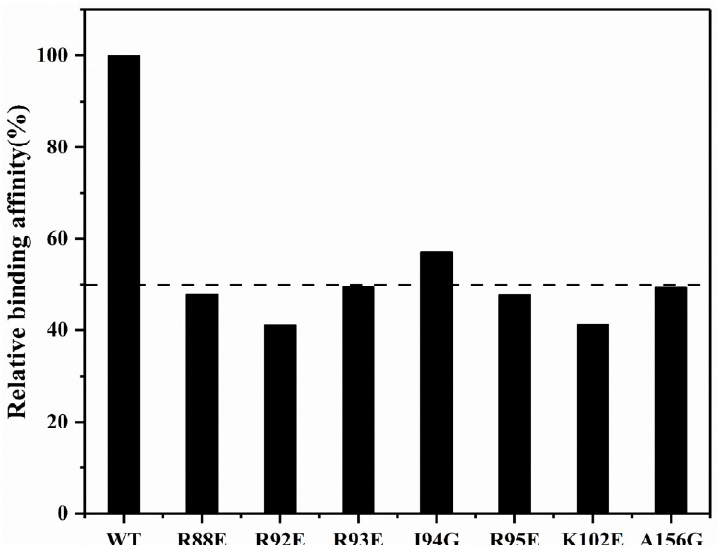
Figure 6. Affinity comparison of SARS-CoV-2 N-NTD WT and mutants for binding suramin. The dashed line denotes the relative binding affinity of 50%.